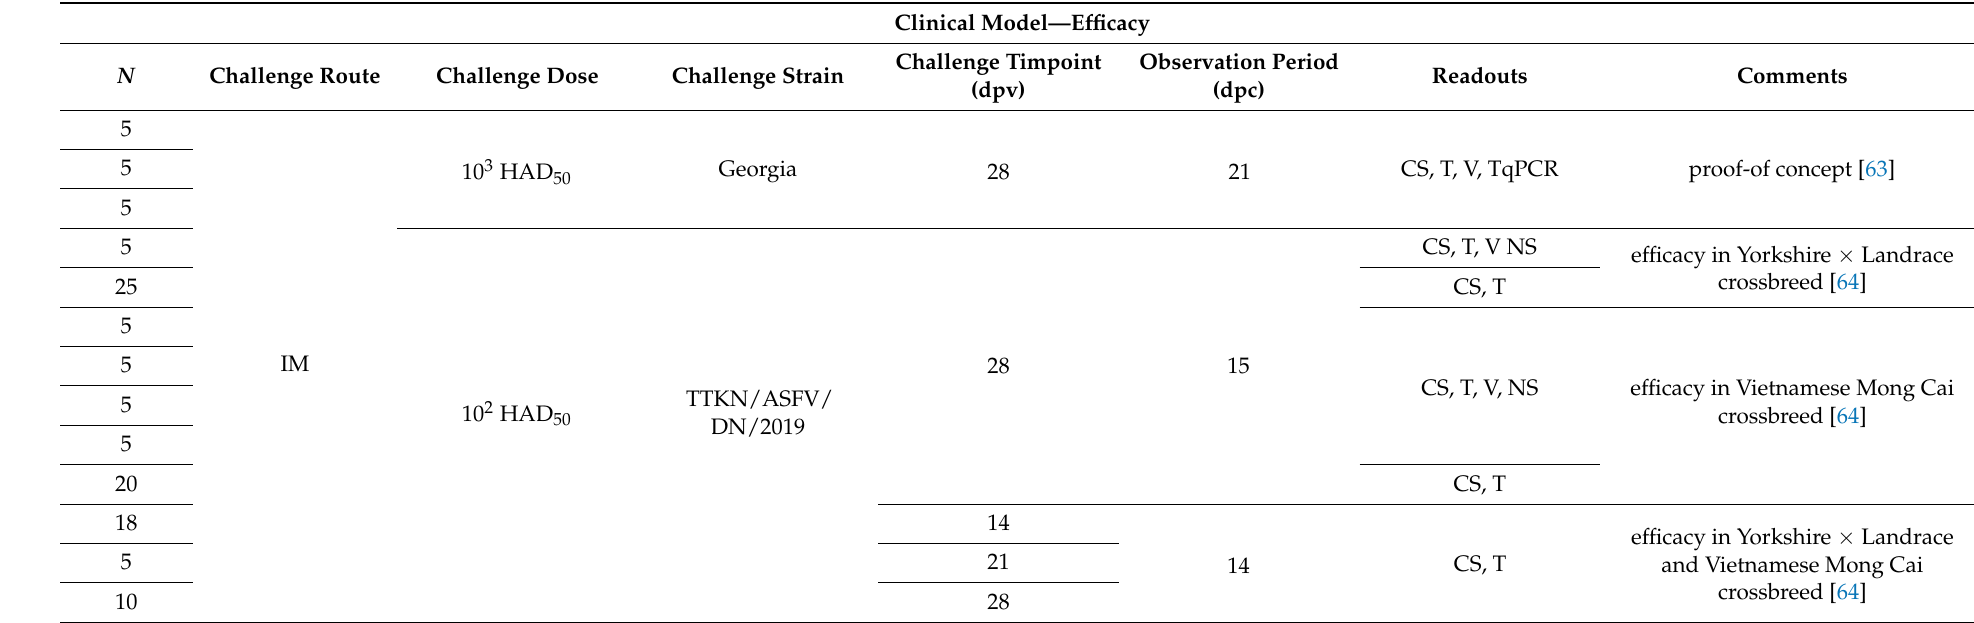
Table 5. ASFV-G- ∆ I177L Licensed Vaccine—Efficacy